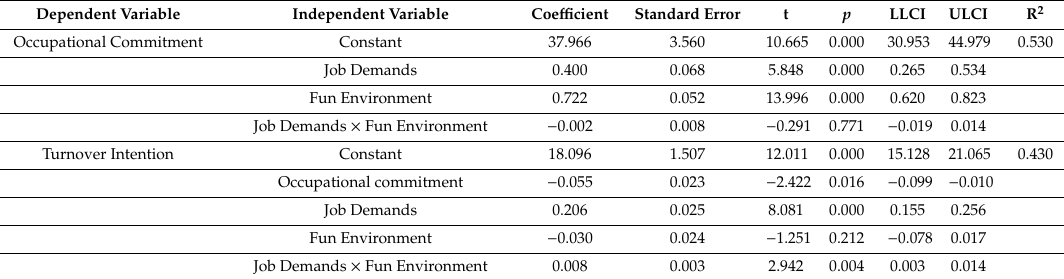
Table 4. Results of Model 8 Test via